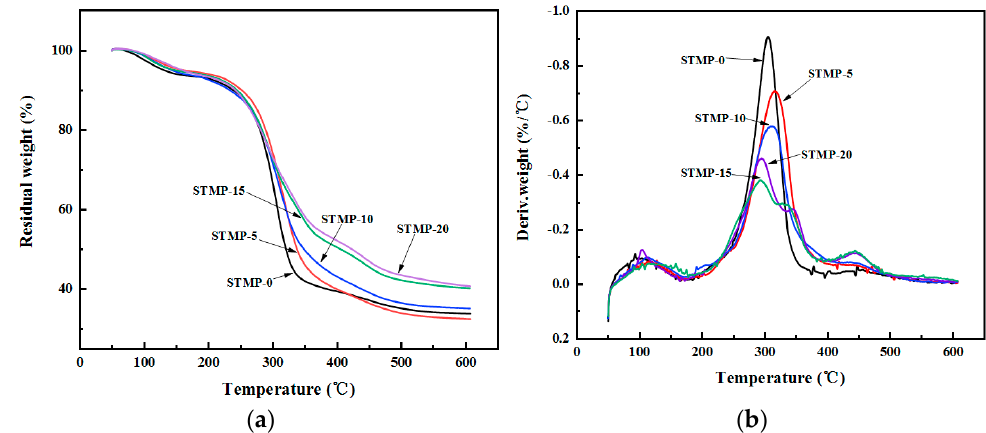
Figure 5. The thermal stabilities of STMP crosslinked hemicellulose films ( a ) thermogravimetric analysis (TGA) curves, ( b ) derivative thermogravimetry (DTG) curves.